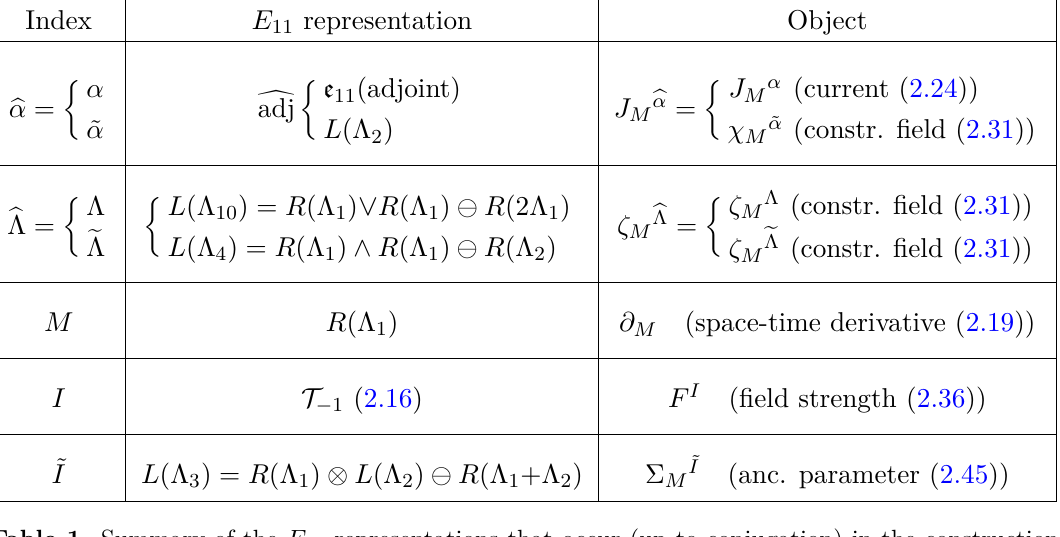
Table 1 . Summary of the E 11 -representations that occur (up to conjugation) in the construction of E exceptional field theory with some associated objects and where they were 11